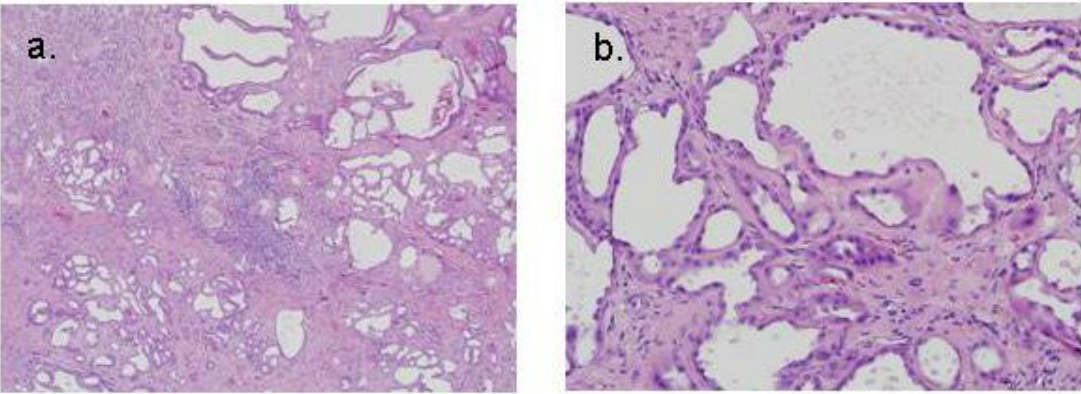
FIGURE 2 . (a) Low magnification (2  ) demonstrates numerous malignant cysts and tubules of variable sizes with occasional entrapped benign renal tubules. (b) High magnification (20  ) demonstrates malignant cysts predominantly lined by a single layer of hobnail cells with mild nuclear pleomorphism and prominent